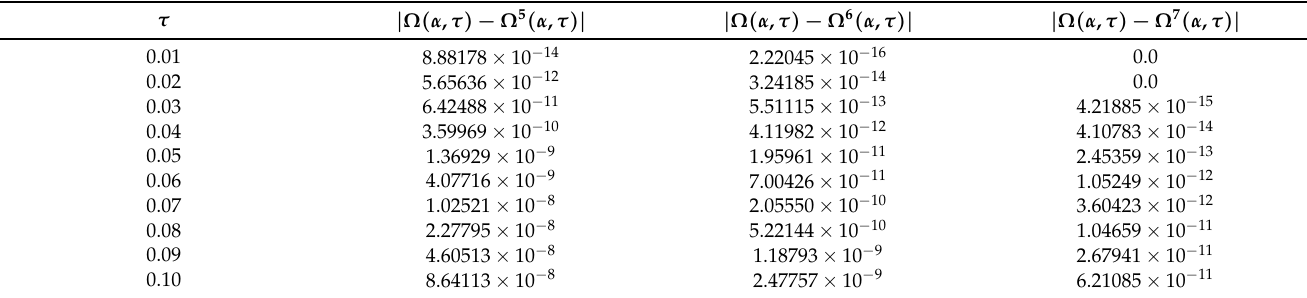
Table 12. The Abs. E of Problem 3 at α = 1.0 when ¯ h = 1.0 in the range τ ∈ [ 0, 0.10 ]